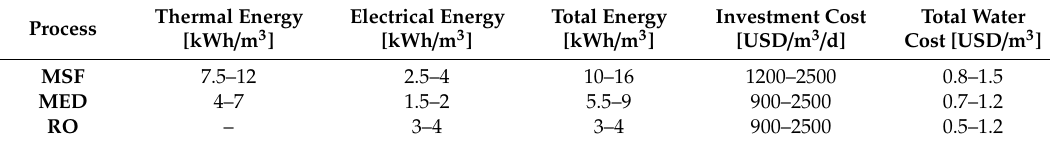
Table 1. Main features of desalination technologies [6].